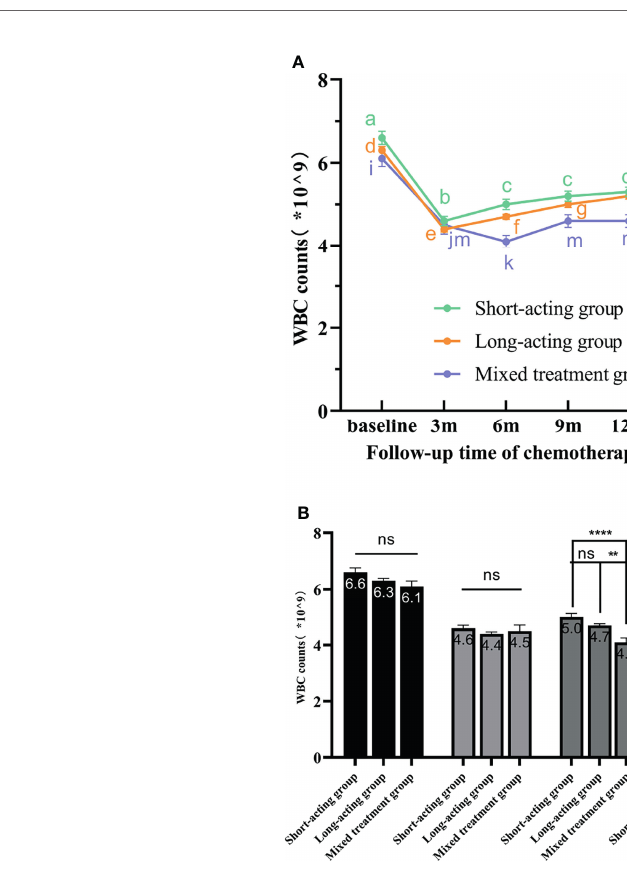
FIGURE 3 | The variation tendency of WBC counts in different G-CSF treated groups. (A) The line chart exhibits the WBC count recovery trend from the three different G-CSF treatment groups at different time points. The different letters (a – m) on the line chart indicate signi fi cant intra-group differences ( p < 0.05). (B) Bars represent the WBC counts means ± standard error of the mean (SEM) from the three treatment groups. “ ns ” indicates that there are no signi fi cant inter-group differences. * indicates signi fi cant inter-group differences at each time point ( p < 0.05 indicated by *, p < 0.01 indicated by **, and p < 0.0001 indicated by ****). WBC, white blood cell; rhG-CSF, recombinant human granulocyte colony-stimulating factor; PEG-rhG-CSF, pegylated recombinant human granulocyte colony- stimulating factor; G-CSF, granulocyte colony-stimulating factor; SEM, standard error of the